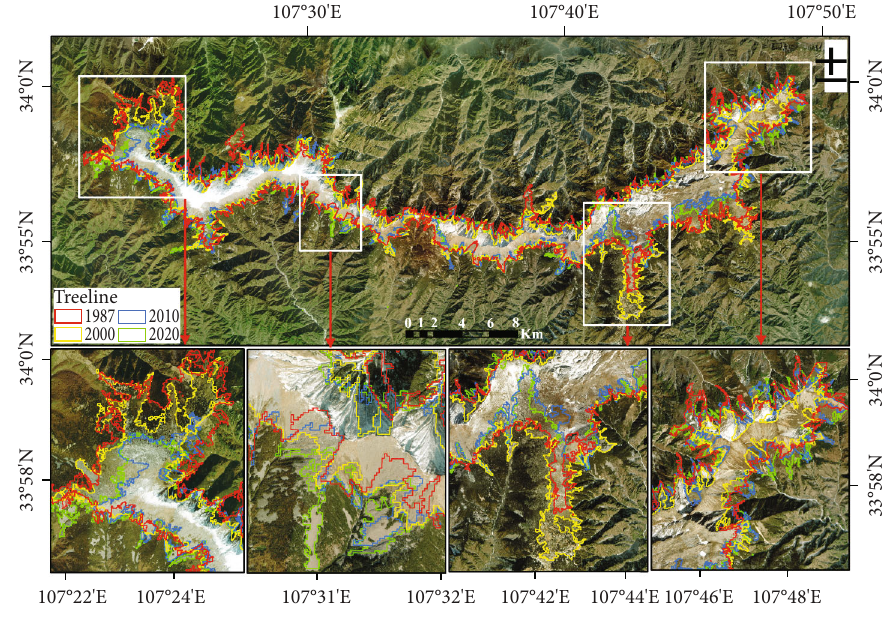
Figure 2: Alpine treeline extraction results (Google Earth image with 0.2 m resolution, May 2020). Table 2: Elevation distribution of the treelines on Taibai Mountain. Elevation range/ Year